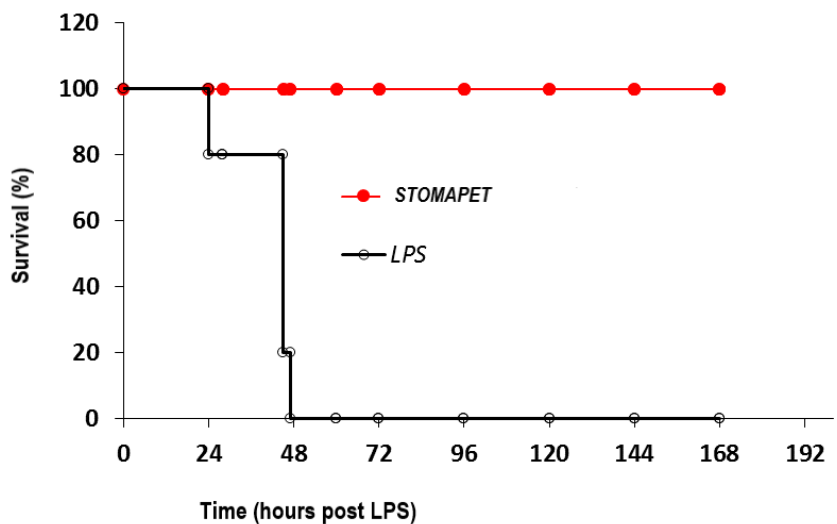
Figure 6. Mortality caused by LPS-induced endotoxemia is prevented by treatment with STOMAPET. Survival rate (%) analyzed according to the time (hours) elapsed since the intraperitoneal injection with LPS (20 mg / kg mouse mass). Group 1 (black line): n = 5 mice, Group 2 (red line): n = 5 mice.